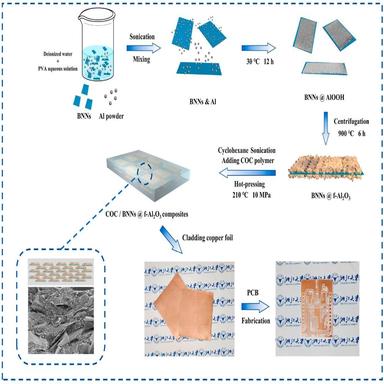
The fabrication process of COC/BNNs@f-Al2O3 composite substrate, copper clad laminate and printed circuit boards.